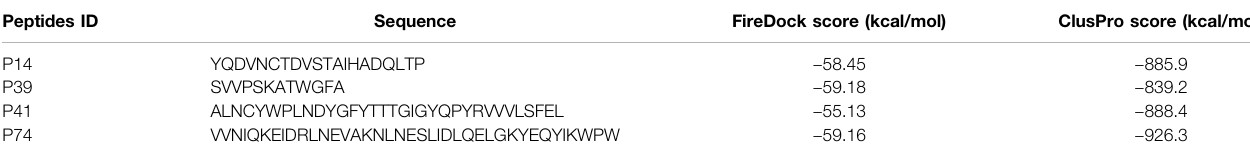
TABLE 1 | Docking score of the top four peptides based on binding energy. The binding energy was calculated through FireDock and ClusPro program. Peptides ID